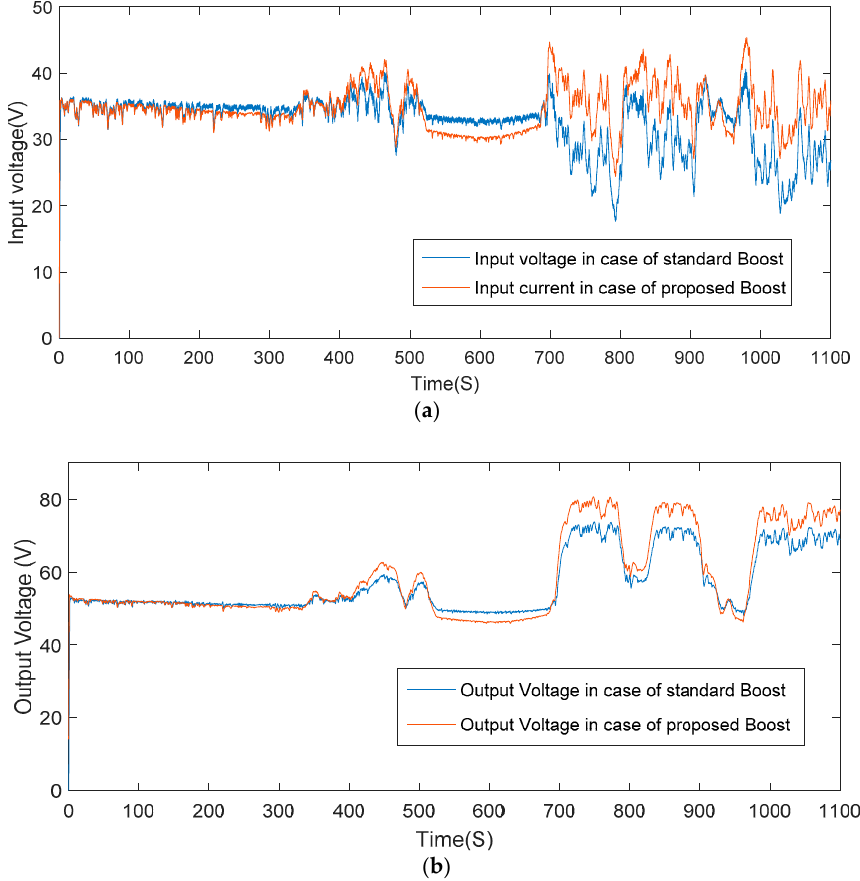
Figure 18. ( a ) Input voltage, ( b ) output voltages.